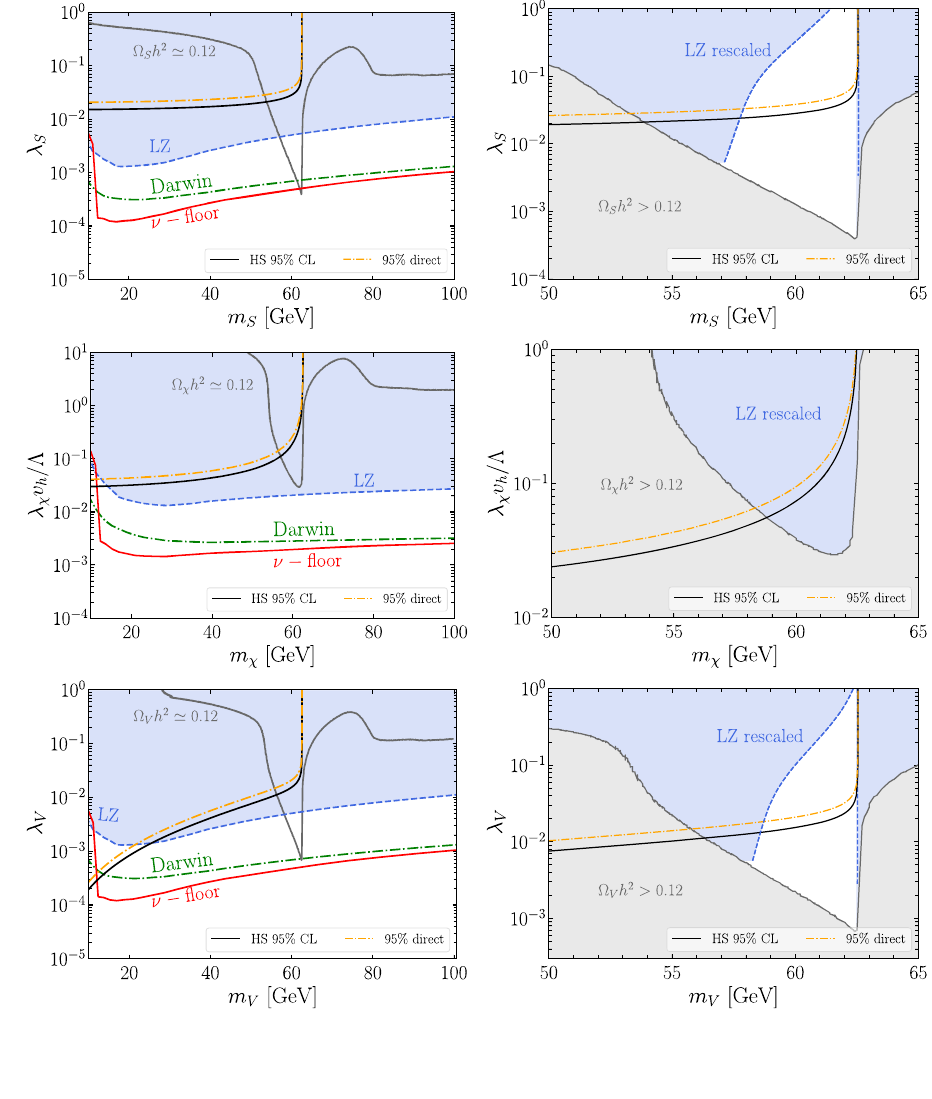
DM (right). Constraints from LZ, projection for Darwin and the neu- trino floor are represented in blue (dashed), green (dotted-dashed) and red (solid) respectively